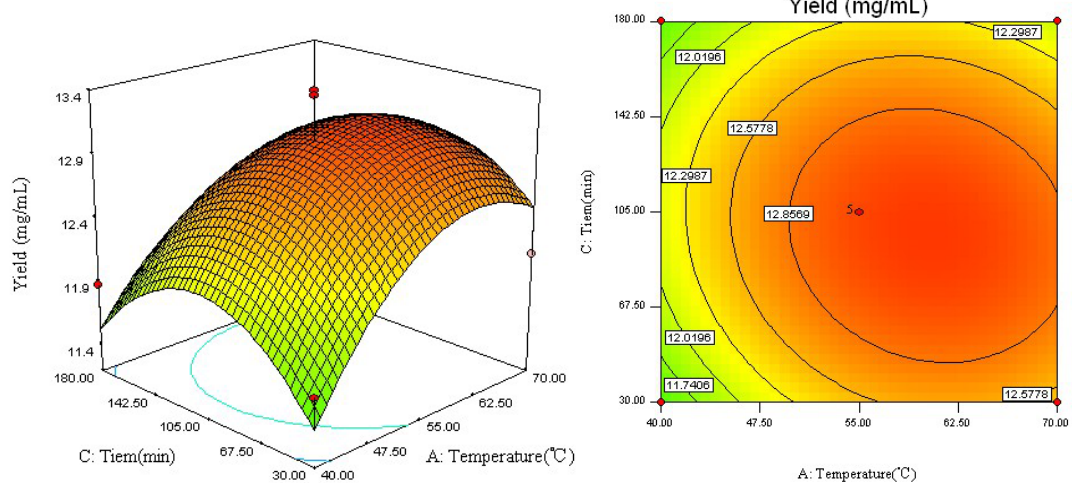
Figure 3. Response surface plot and contour plot of reaction temperature and reaction